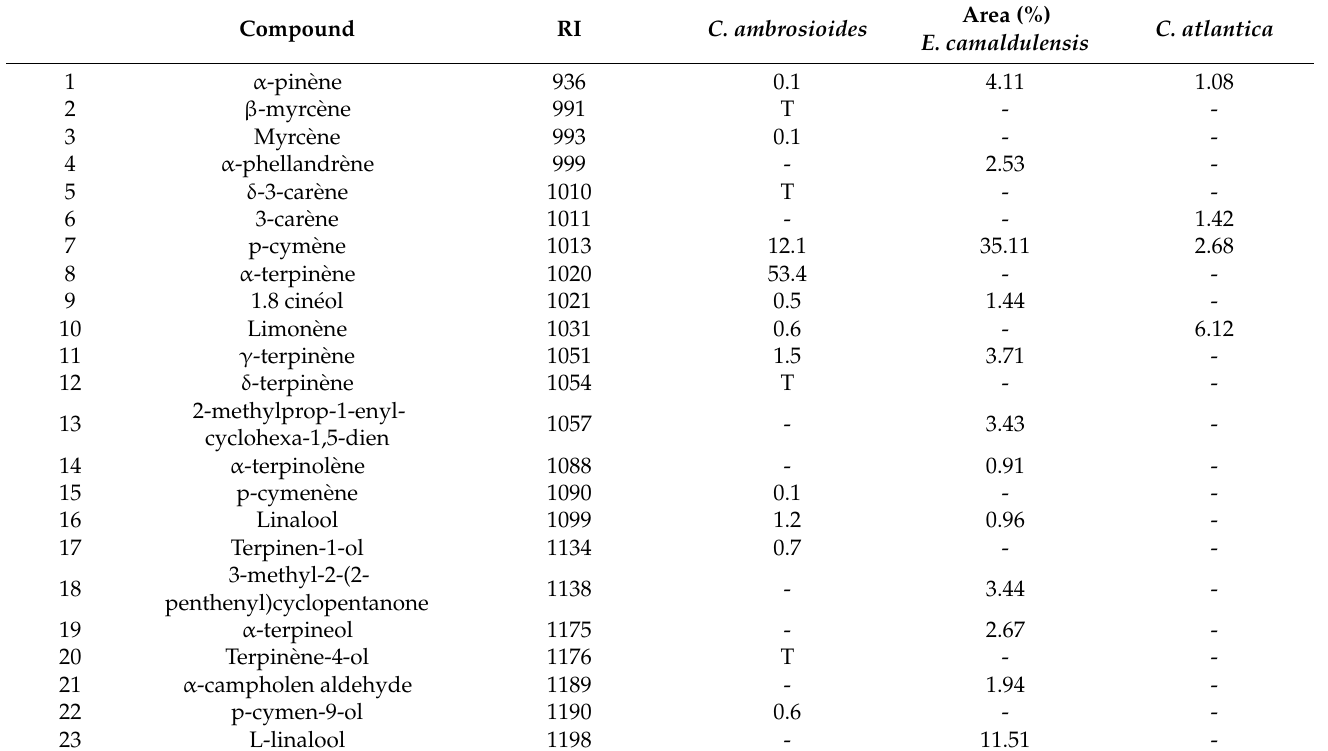
Table 1. Chemical composition of the three oils